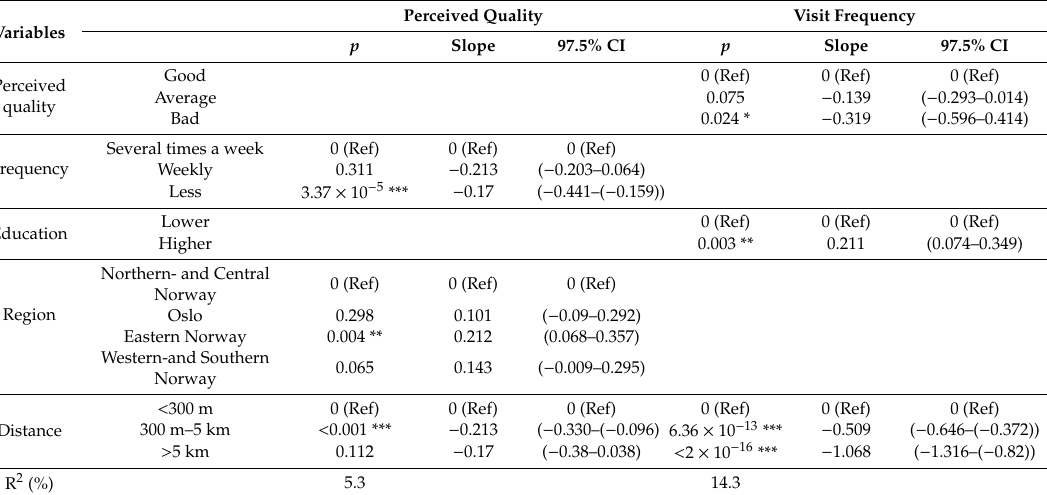
Table 3. Linear regression model outcomes with stepwise backward inclusion of significant predictor variables for visit frequency and quality perception based on a sample of 1010 adult